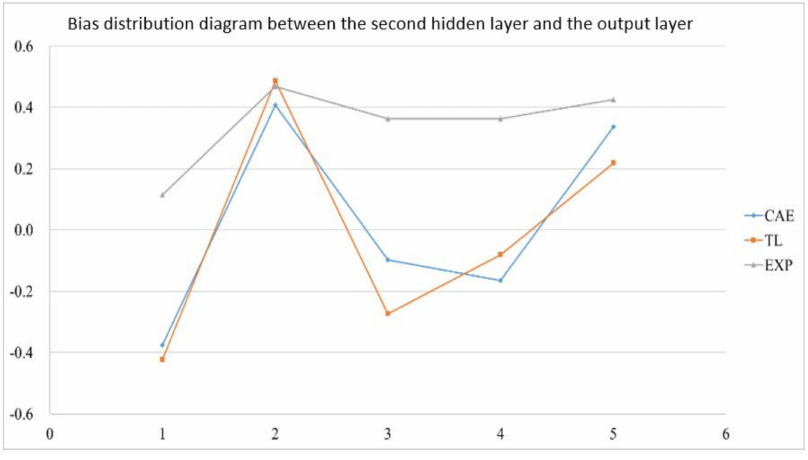
Figure 25. Bias distribution diagram between the second hidden layer and the output